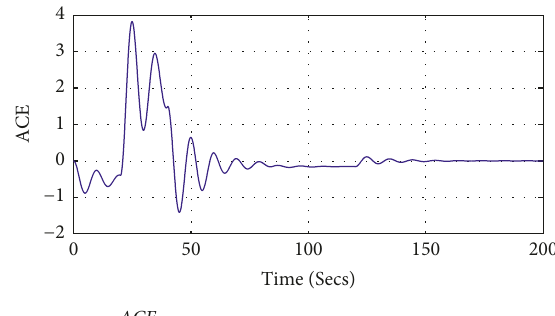
Figure 6: Evaluation of ACE in equation (38) in Theorem 3.